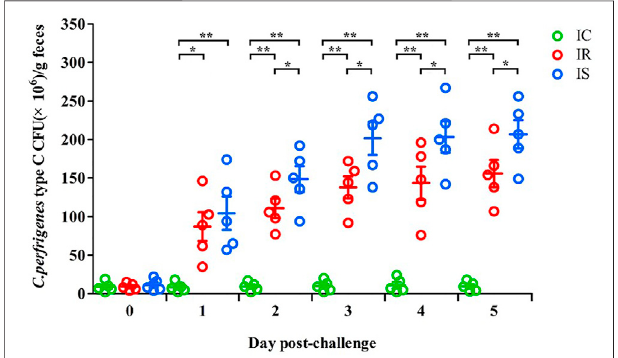
FIGURE 1 | The fecal shedding levels of piglets in the IR, IS, and IC groups after Cp infection. Note: Fecal CFUs were determined by plate count method. The horizontal line represents the mean. Green circles represent the IC group, red circles represent the IR group, and blue circles represent the IS group. An asterisk denotes a signi fi cant difference (* p < 0.05, ** p <